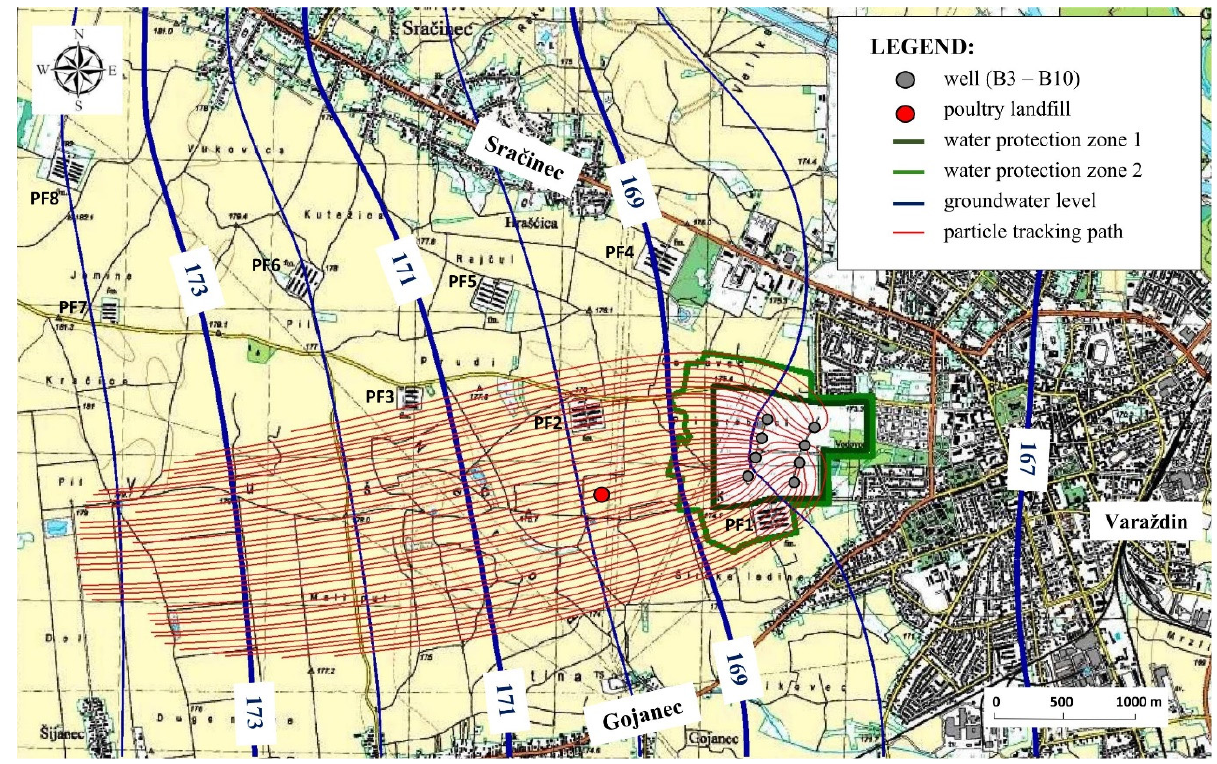
Figure 5. Groundwater flow simulation.